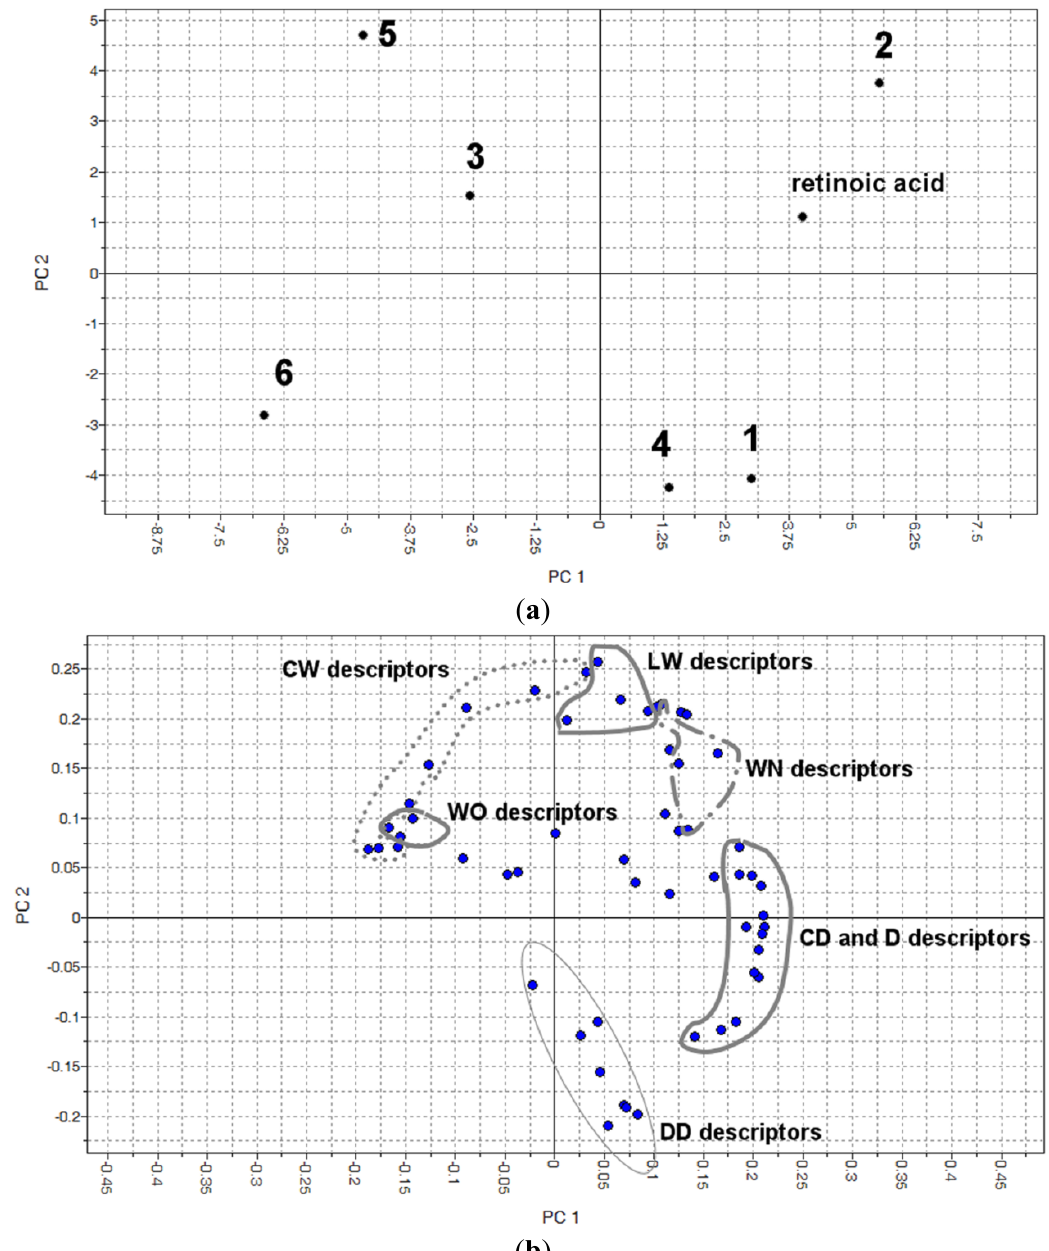
Figure 3. Scores ( a ) and loadings plot ( b ) of PCA generated using 57 descriptors generated by molecular interaction fields for probes water, amide nitrogen, carboxylic oxygen and DRY